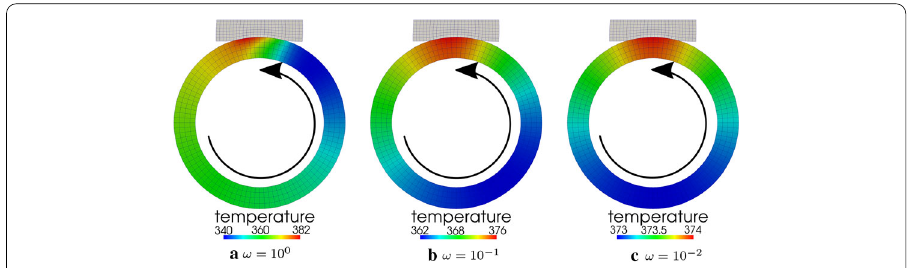
Fig. 5 Frictional heating of a rotating ring. Temperature distribution after one full rotation ( α = 2 π ) at different angular